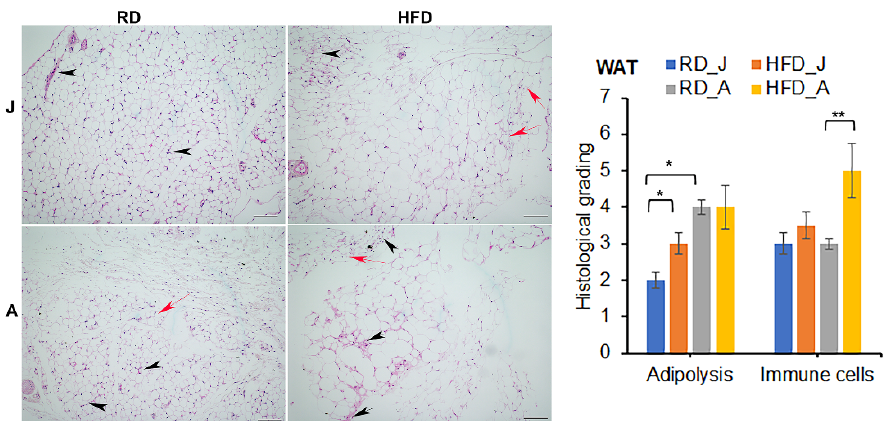
Figure 4. Mtb infection alters adipose tissue pathology by causing infiltration of immune cells into adipose tissue (black arrowheads), and loss of adipocytes (red arrows, smaller adipocytes) in juvenile and adult aerosol Mtb infected mice fed RD and HFD, as shown by H&E staining. Adult infected mice showed increased adipose tissue pathology compared to juvenile infected mice as demonstrated by H&E staining at 30 dpi. ( × 10 magnification, scale bar = 100 µ m). Each class was graded on a 5-point scale ranging from 0 to 5 as discussed in Materials and Methods. Values plotted are mean ± standard error (SE) from n = 5. The error bars represent the standard error of the mean. * p < 0.05, and ** p < 0.01, between the indicated groups.